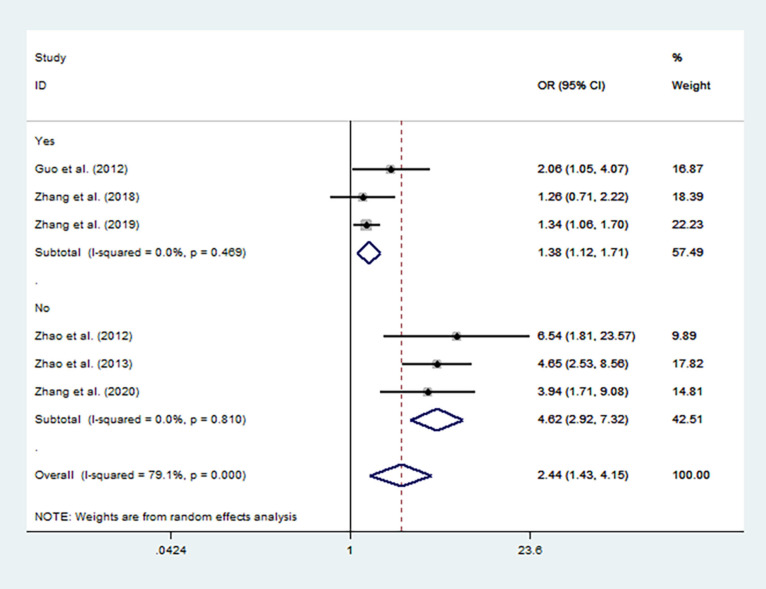
Forest plot for the association between MTHFR C677T polymorphism and autism susceptibility in homozygous genetic model stratified by HWE status of controls.